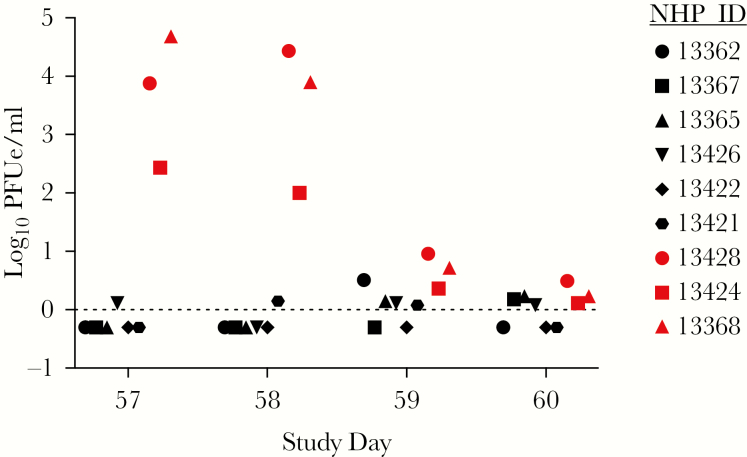
Viremia measured by quantitative real-time polymerase chain reaction assays. Ribonucleic acid (RNA) was isolated from sera and assayed using Chikungunya virus La Reunión (CHIKV-LR)-specific primers and probe. Cycle threshold (Ct) values were converted to plaque-forming units per milliliter (PFU/mL) from a standard curve generated from serially diluted RNA prepared from CHIKV-LR that was titered by plaque assay. Black symbols represent MV-CHIK vaccinated nonhuman primates (NHPs), whereas the red symbols indicate sham-vaccinated control animals.